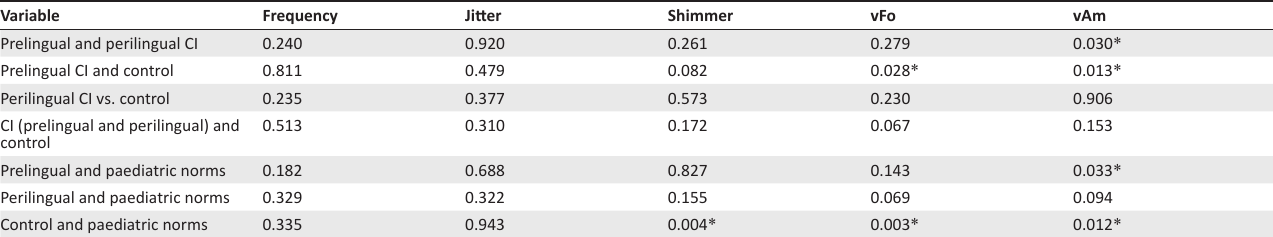
TABLE 3: Differences in vocal parameter outcomes between groups. Variable